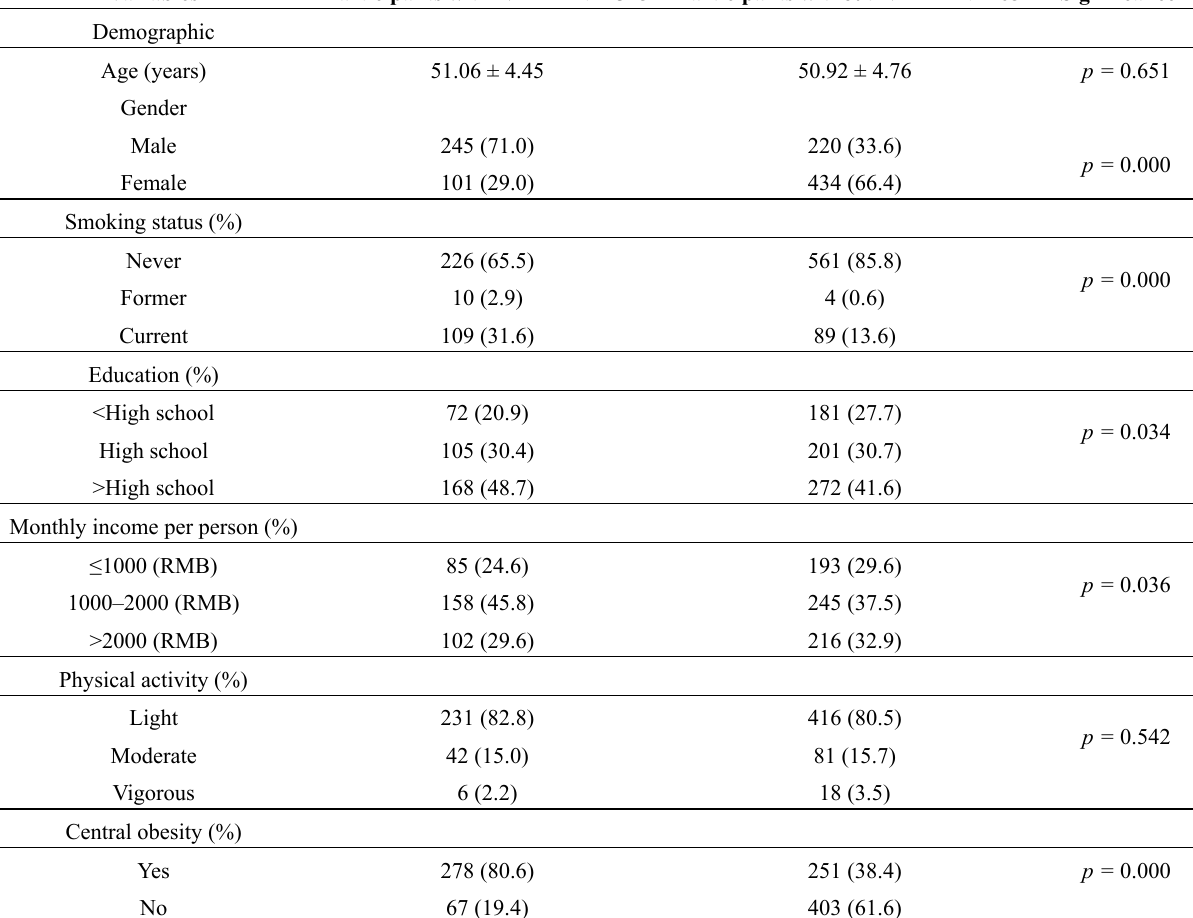
Table 1. Demographic and lifestyle characteristics of participants in the Hefei Nutrition and Health